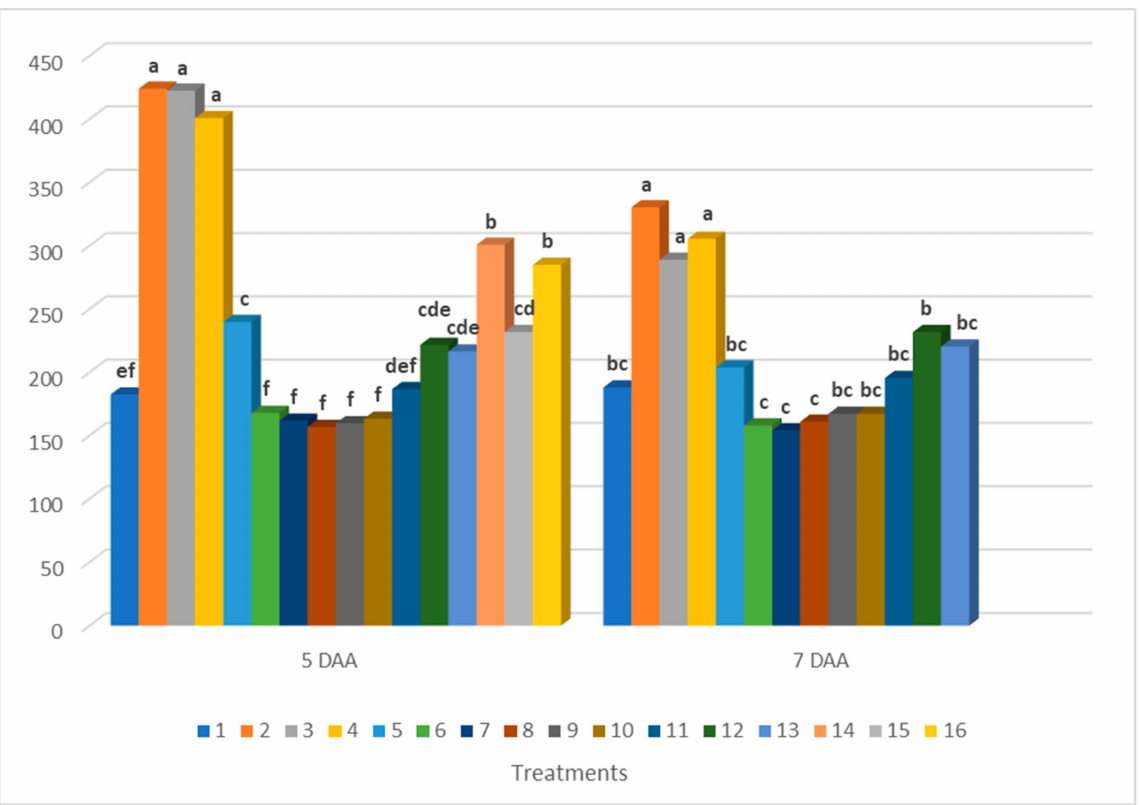
Figure 1. The effect of herbicides on F 0 —minimum fluorescence of dark-adapted state (non-nominated units). a–f different letters indicate statistically different mean LSD ( p < 0.05) 5 DAA = 34.80; LSD ( p < 0.05) 7 DAA = 44.02. (1—untreated; 2—16 herbicides applied at different pH of the spray solution: 2–4—mesotrione; 5–7—nicosulfuron; 8–10—rimsulfuron; 11–13—mesotrione + nicosulfuron + rimsulfuron + adjuvant; 14–16 bromoxynil; details description of treatments is included in Table